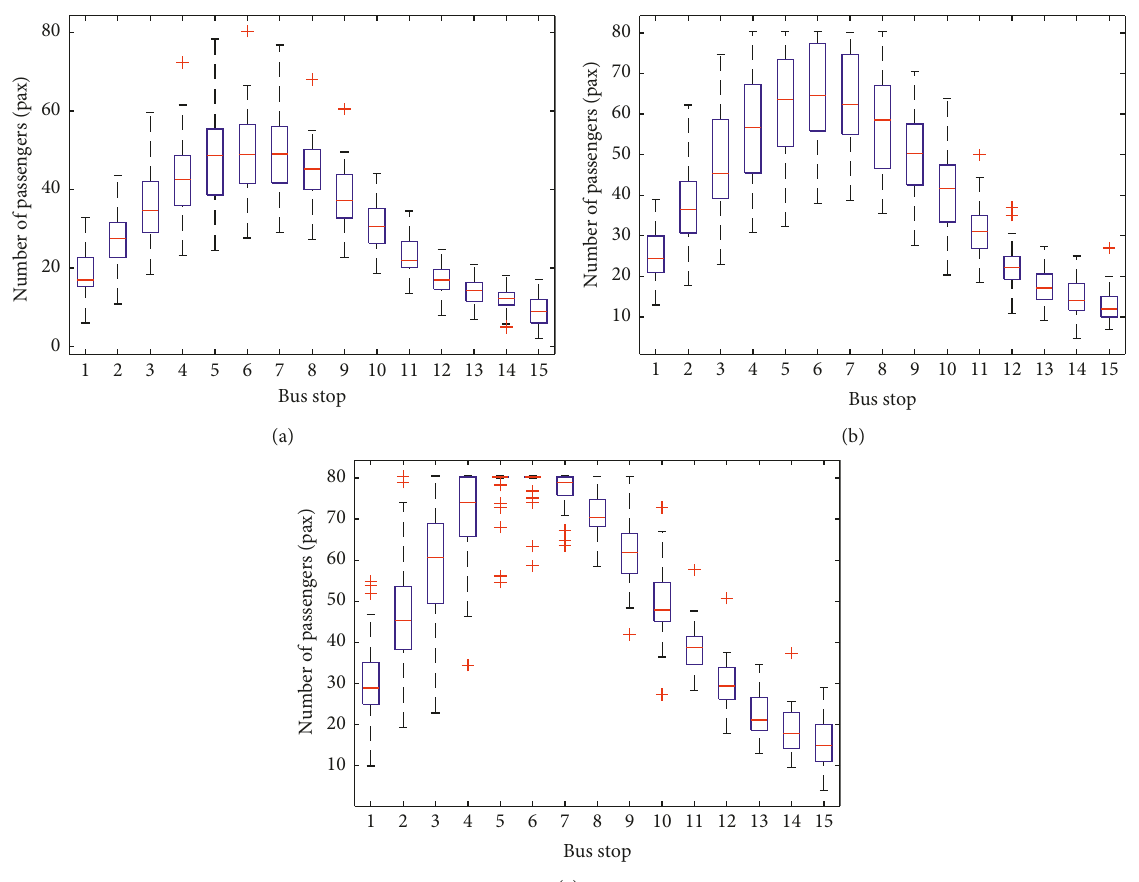
Figure 6: Distribution of number of passengers on buses at each bus stop. (a) Group r1. (b) Group r2. (c) Group r3.